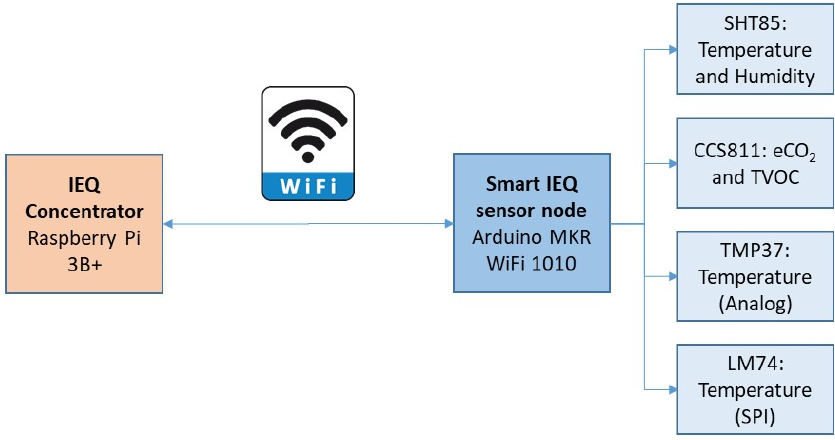
Figure 3. Hardware diagram for the IEQ monitoring system prototype.